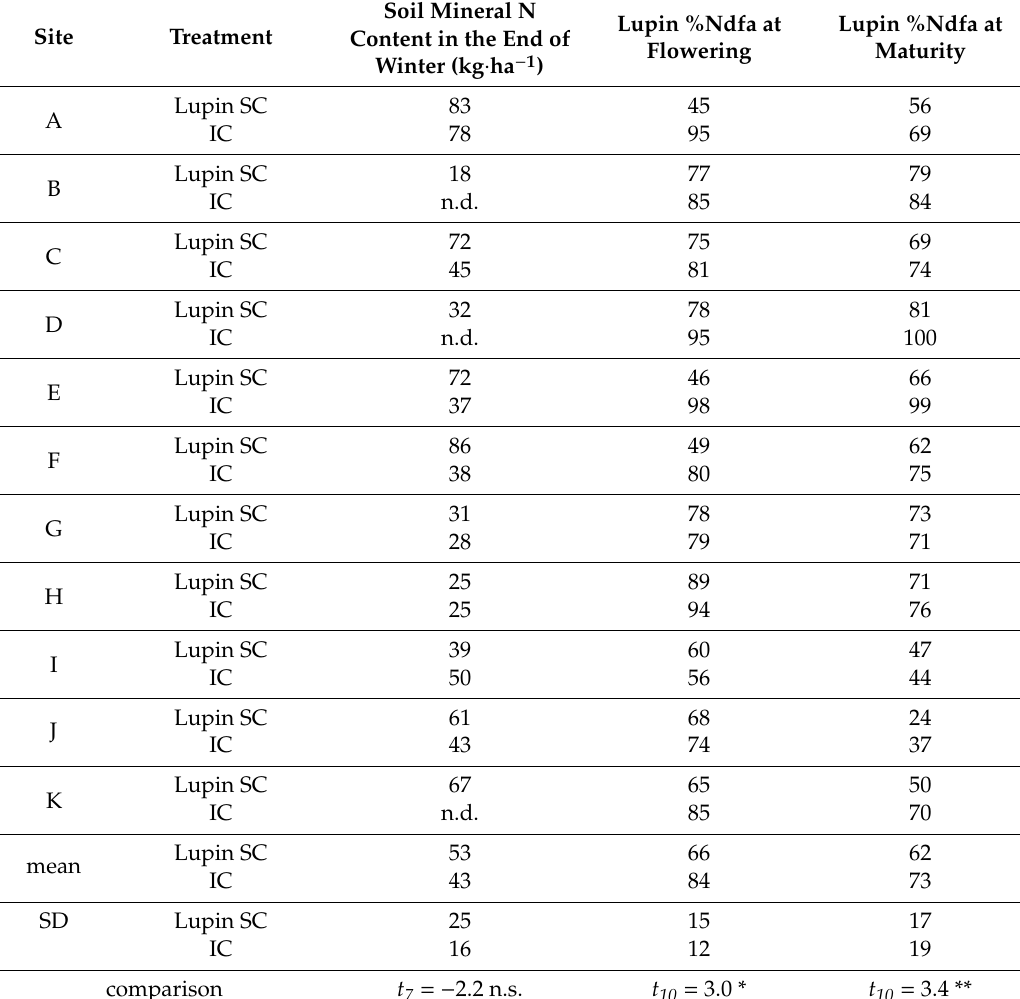
Table 5. Soil mineral N content and lupin %Ndfa (percentage of N accumulated in aboveground parts derived from N 2